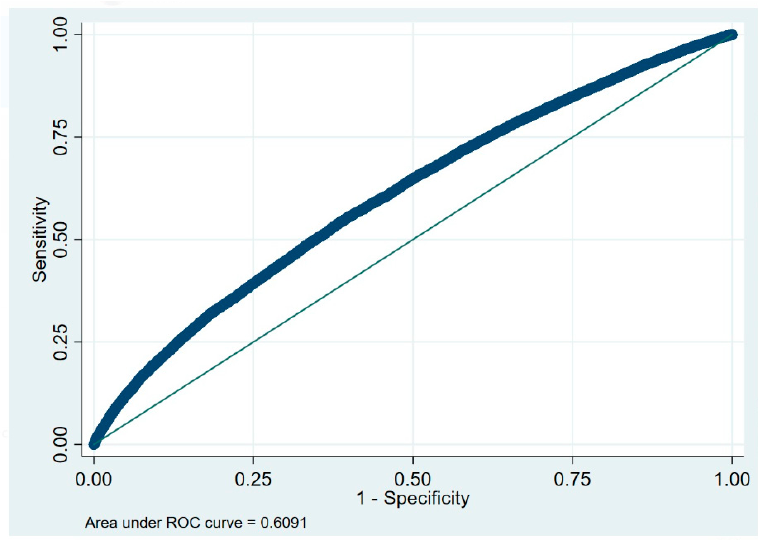
Figure 6. The ROC curve for the second